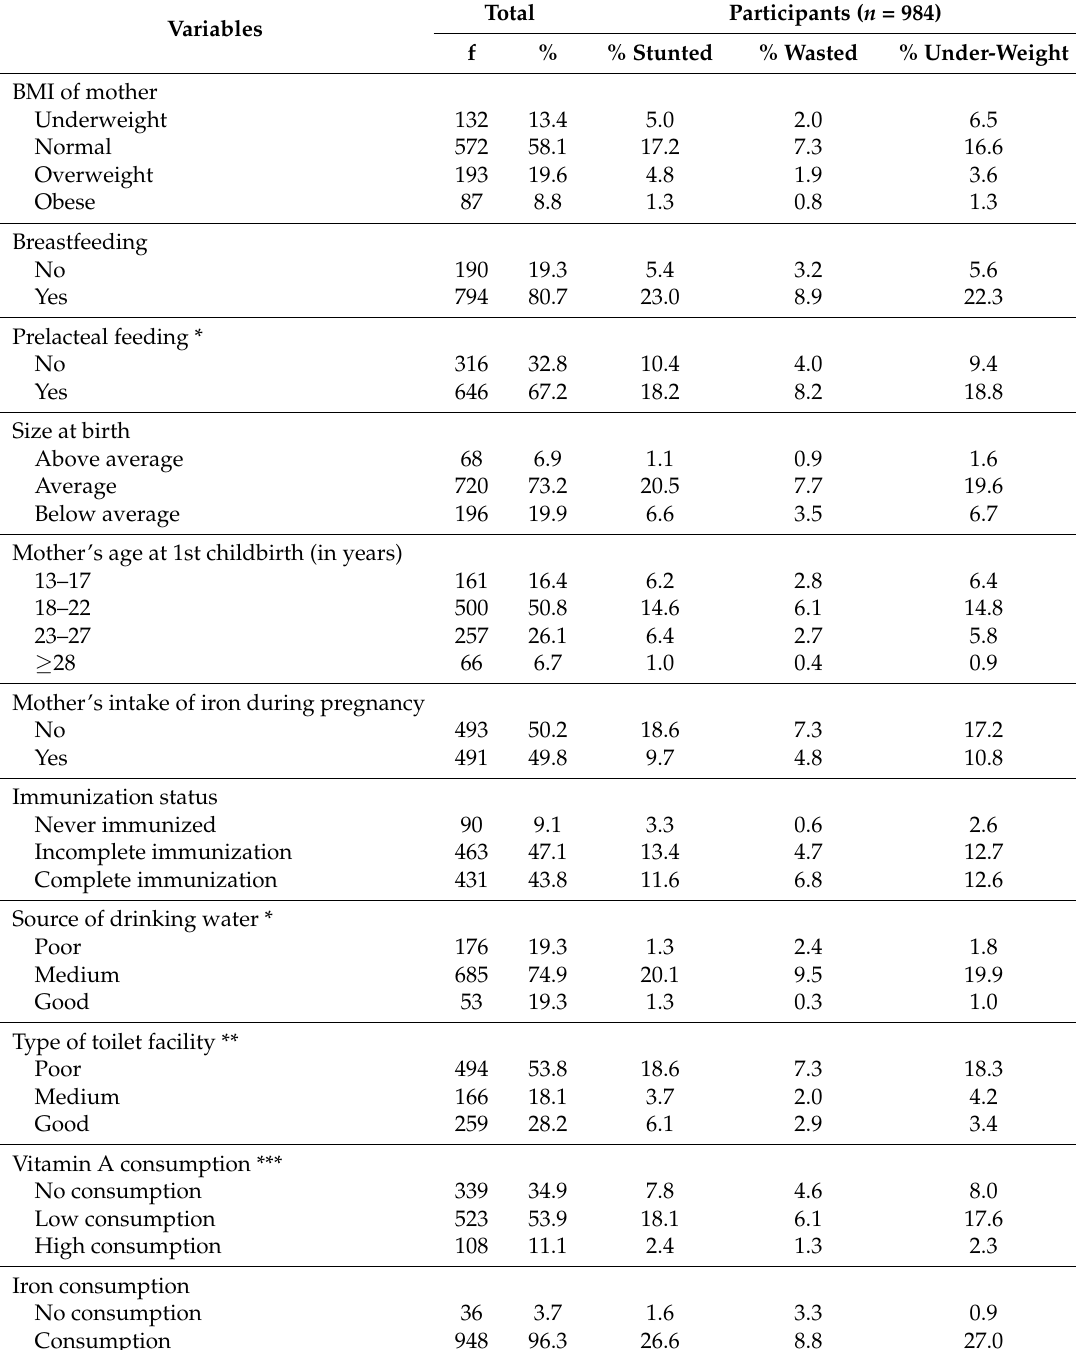
Table 2. Health and nutrition related factors of children under two years of